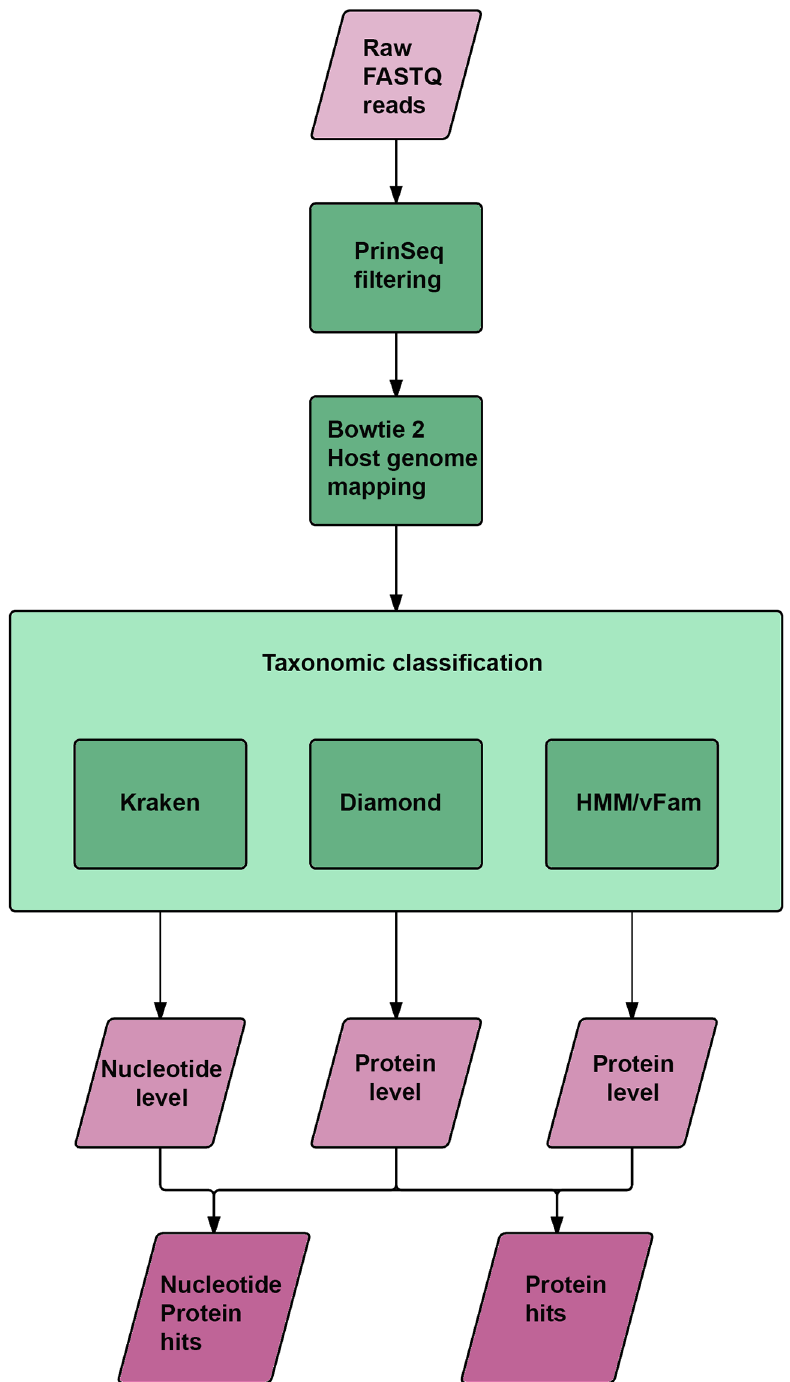
Fig 2. Schematic illustration of the bioinformatic pipeline. Raw data from the sequencing platform, in FASTQ format, was processed by PrinSeq to select high quality reads. The fractions of high quality reads were then mapped towards the porcine genome, using Bowtie 2, to remove host sequences. The unmapped reads were then classified by three different methods, Kraken, Diamond and HMM/vFam. The resulting three datasets were grouped in two datasets, one representing reads classified on nucleotide and protein level and one representing reads classified only on protein level.